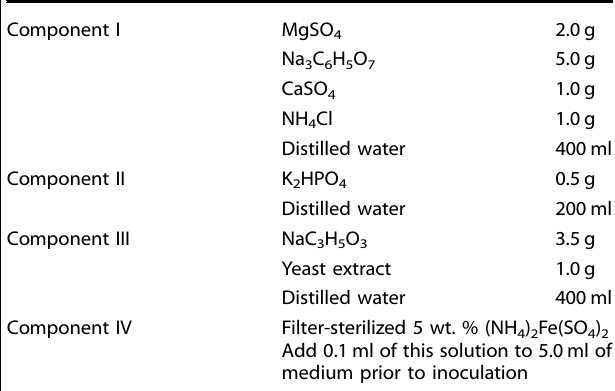
Table 2. Chemical composition of 1L ATCC1249